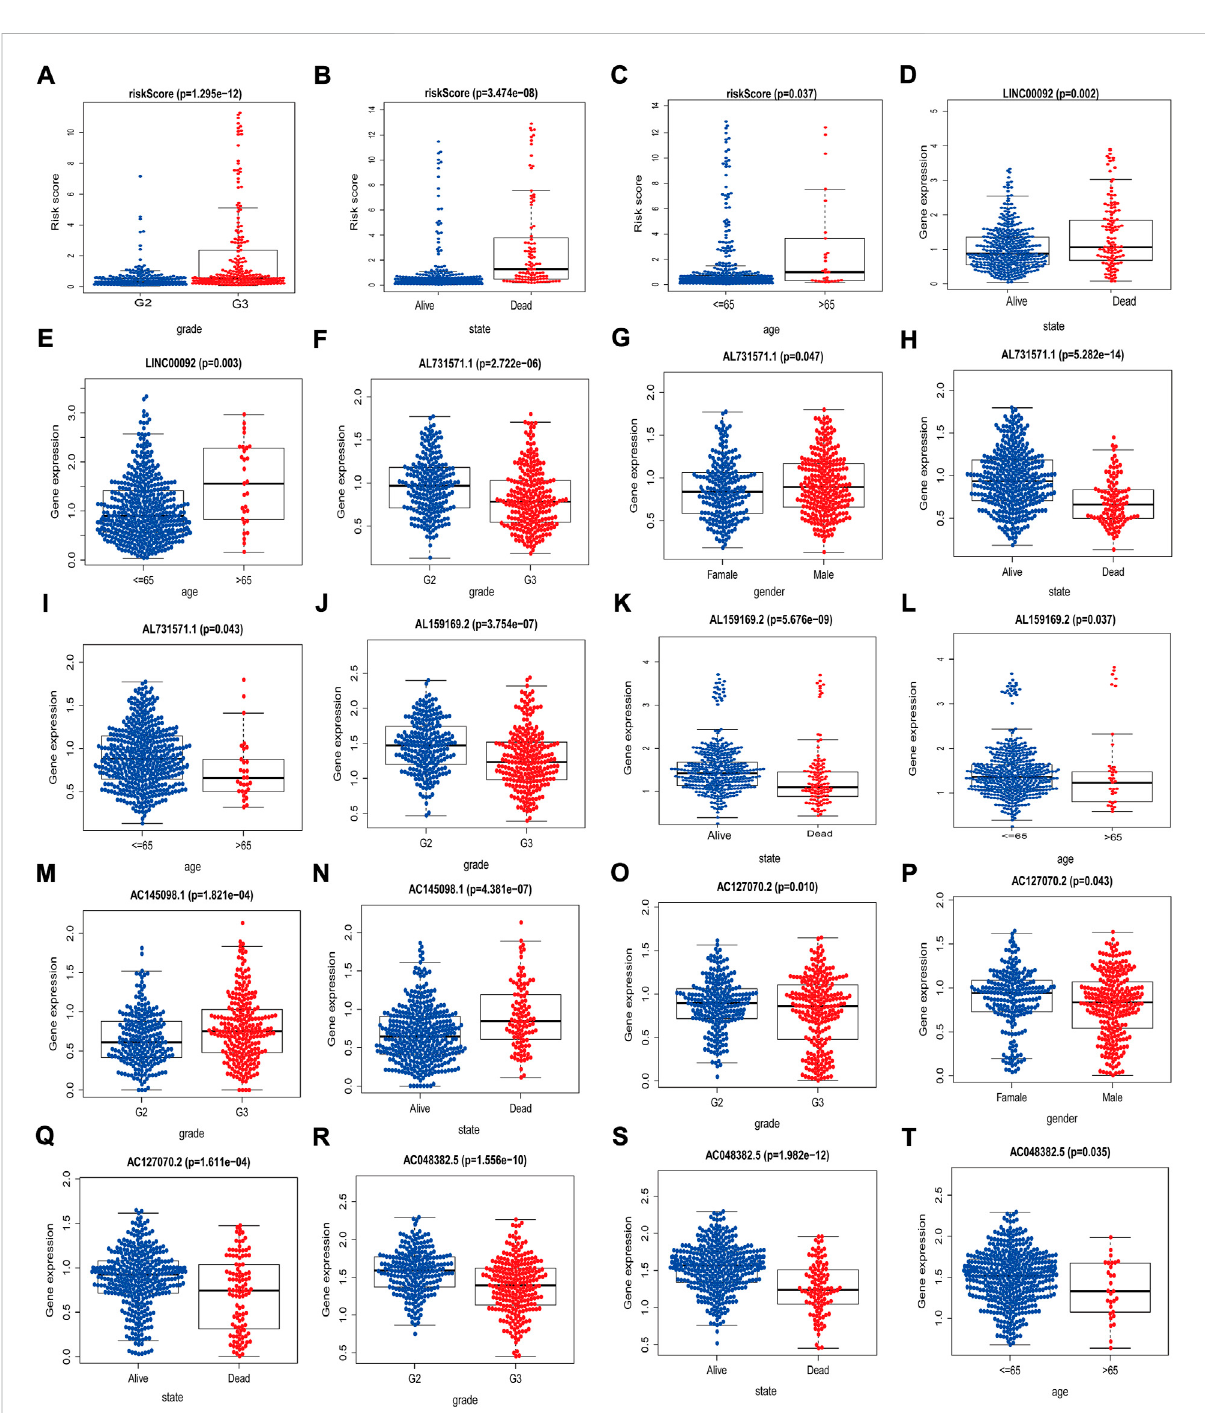
FIGURE 4 Associationsbetweenrisk scores/related lncRNAs and clinical features. (A – C) Association between risk score and gender,state, and age. (D – E) Associationbetween LINC00092 expressionlevelandstate,age. (F – I) Associationbetween AL731571.1 expressionlevelandgrade,gender,stateand age. (J – L) Association between AL159169.2 expression level and grade, state and age. (M – N) Association between AC145098.1 expression level and gradeandstate. (O – Q) Associationbetween AL127070.2 expressionlevelandgrade,genderandstate. (R – T) Associationbetween AC048382.5 expression level and grade, state and